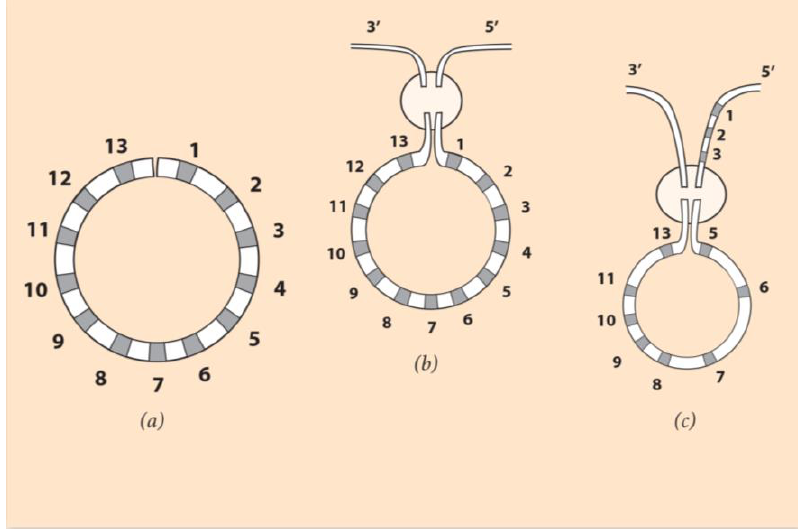
Figure 4. Circular ordering of Hoxgenes. (Adapted from S. Papageorgiou (2016) Current Genomics 17: 444 – 449) [37]. ( a ) The linear DNA is bent, and the two ends of the Hox cluster come close together. ( b ) In the encircled domain, the ends Hox1 and Hox13 of the cluster are connected to the 3’ and 5’ end of the flanking chromosome. If Hox1 is attached to the 3’ end and Hox13 to the 5’ end, the produced linear arrangement is the normal one and could represent the observed A. planci gene ordering. ( c ) If Hox5 is connected to the 3’ end and Hox13 to Hox3 on the flanking chromosome, the linear ordering is the sea urchin Hox cluster arrangement, as shown in Figure 3.